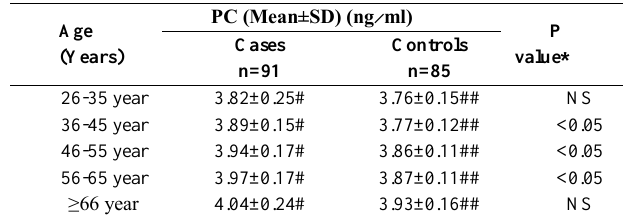
Table 2: Distribution of PC of the study population according to age